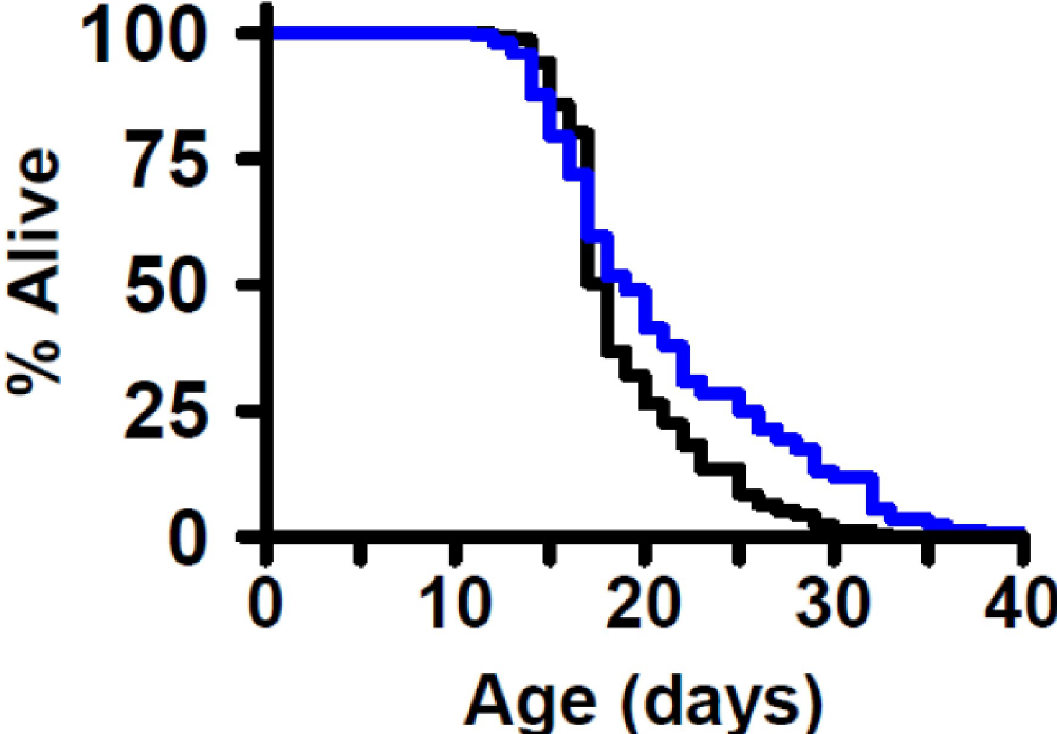
Fig 4. RNAi knockdown of tsp-7 increases worm lifespan. Survival curves C . elegans fed either empty vector (EV) RNAi (black, n = 317) or tsp-7(RNAi) (blue, n = 312).